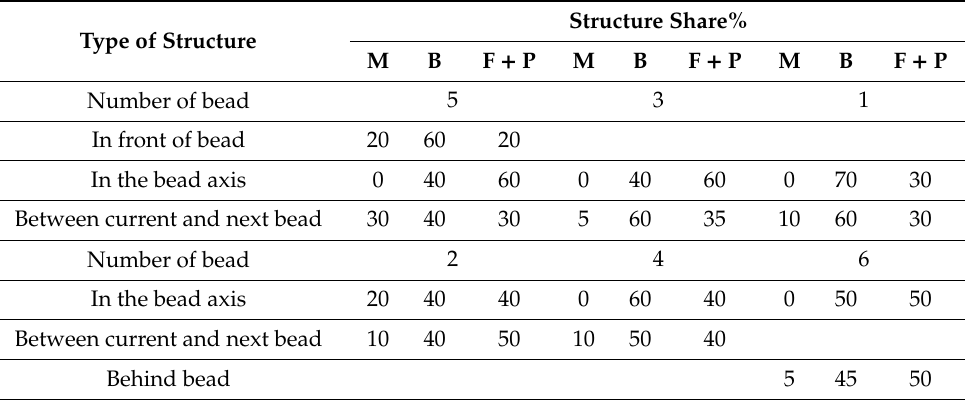
Table 5. Shares of structures in the surfaced welds on plate B.